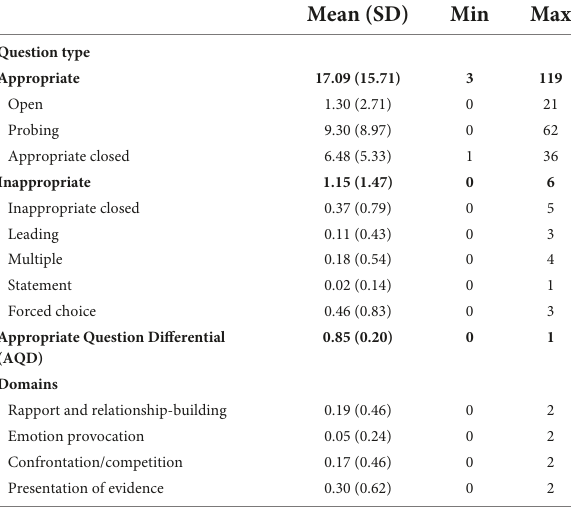
TABLE 5 Frequencies of separate techniques in Study 2 ( N =